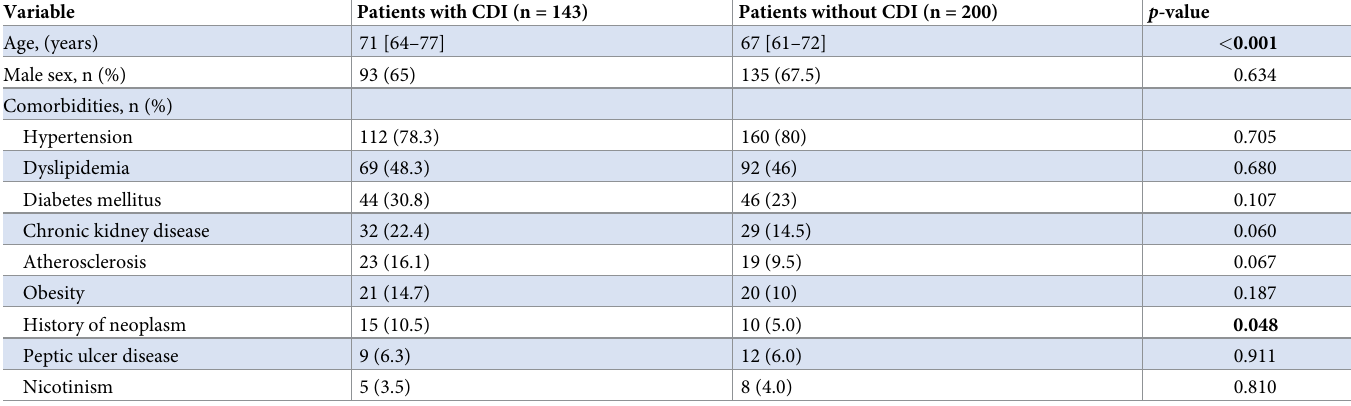
Table 1. Baseline